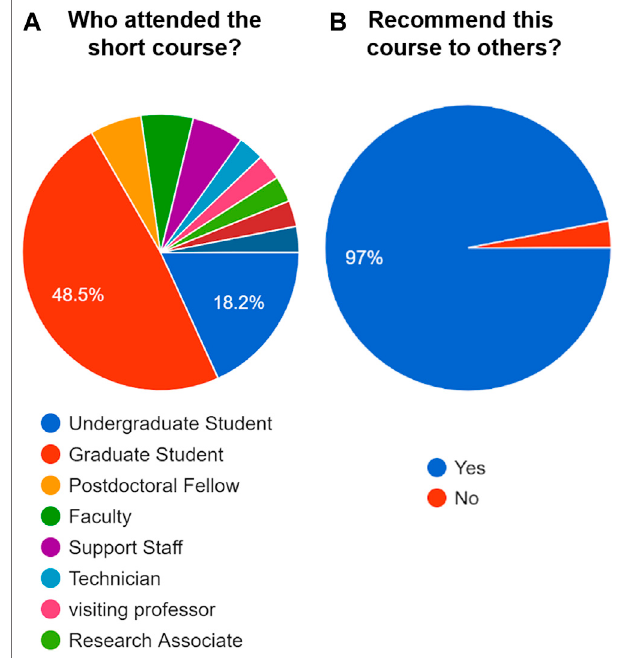
FIGURE 4 | Demographics of the short course participants. (A) Indicationoftheacademicleveland/orposition. (B) Responsesofparticipants from (A) to the question: “ Will you recommend this short course to others?